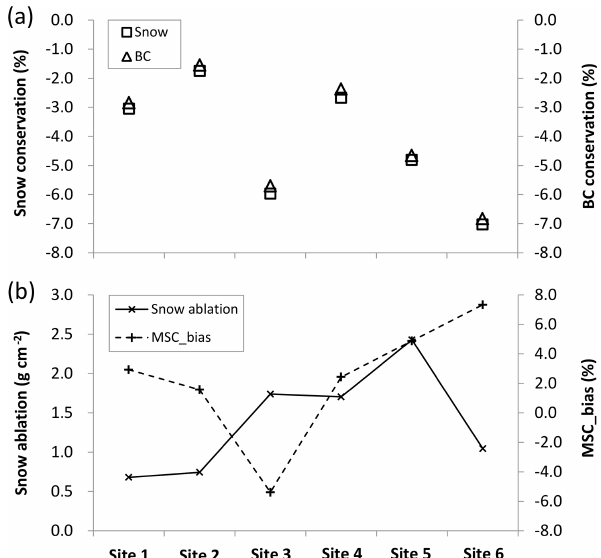
Figure 4. The deviations from 100% conserved for snow and BC after ablation (a) , snow ablation ( h 1 · ρ 1 − h 2 · ρ 2 ) during the melt event and the bias ((MSC_2-MSC_1)/MSC_1) ∗ 100% of estimated MSC based on Eq. (2) (b) . The ticks on the x axis are matching sites given in Table 1.